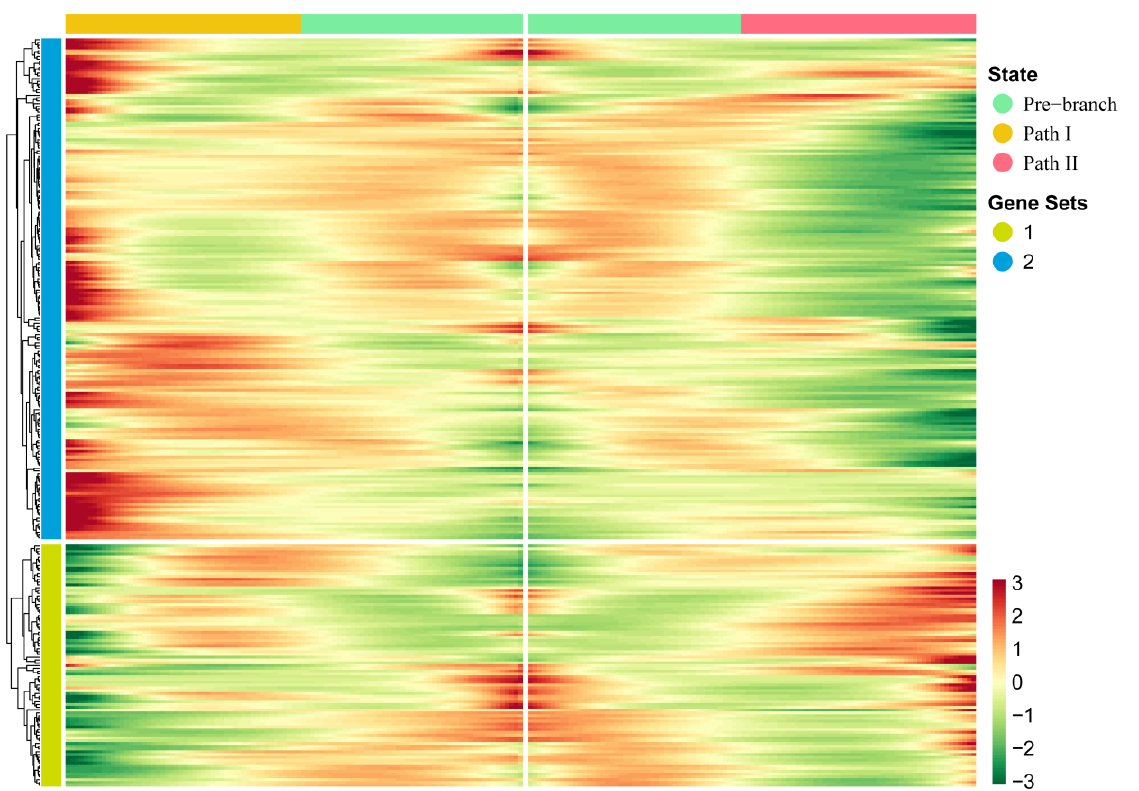
Figure 3. Key genes driving the occurrence of the branch point: The heatmap of gene expression levels during the progression of OSCC. Gene clusters were generated by hierarchical clustering.